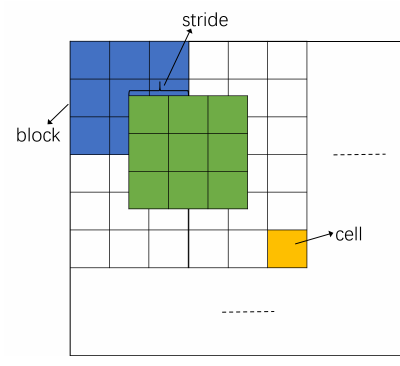
Figure 2. Scheme of